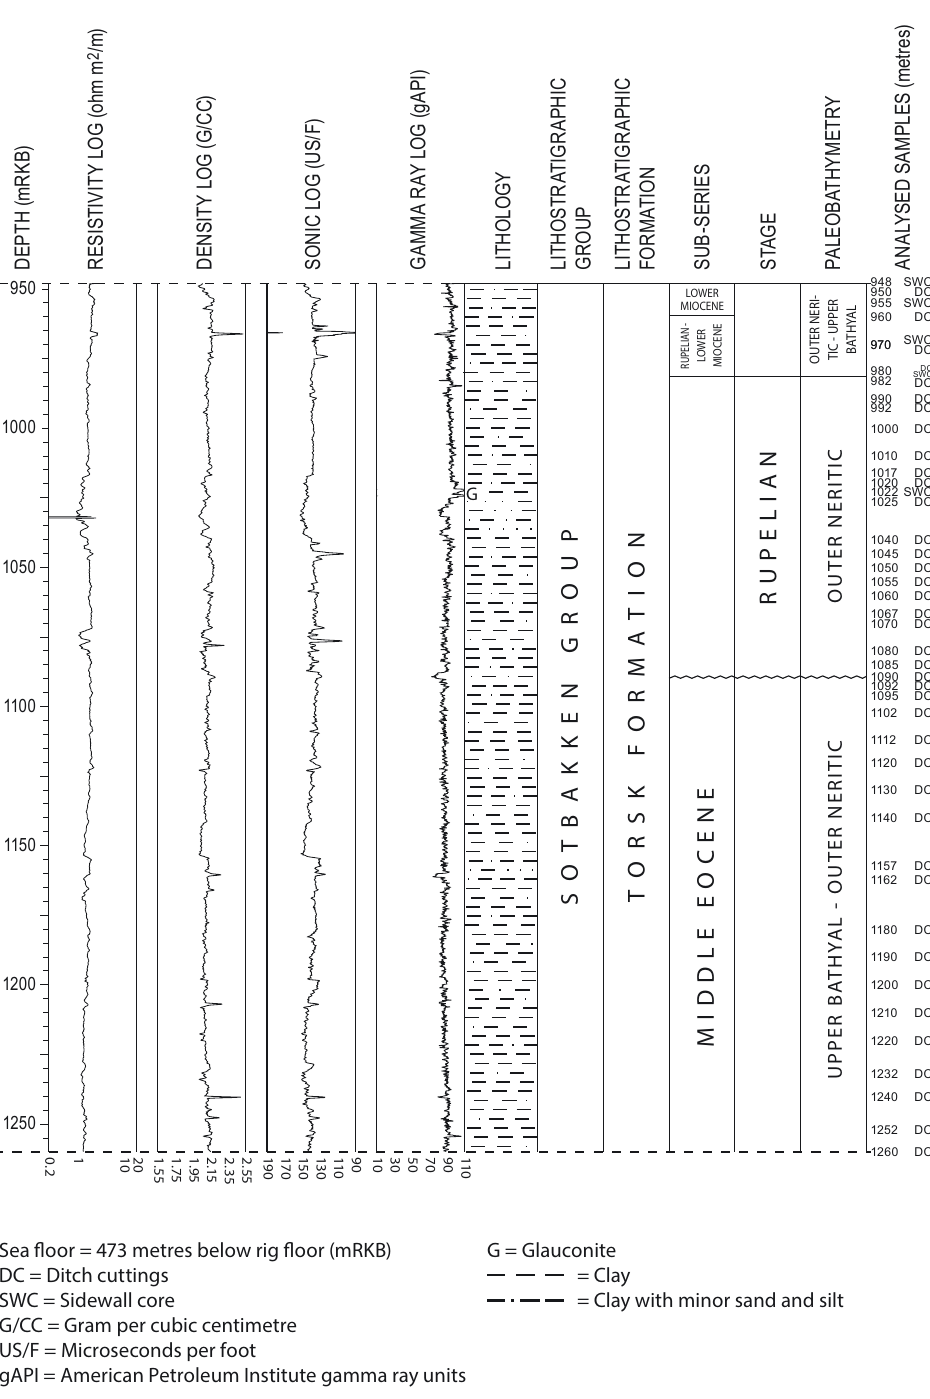
Figure 14. Well summary figure including resistivity log, density log, sonic log, gamma-ray log, lithology, litho- stratigraphic units, sub-series, stage, paleobathymetry and analysed samples for the middle part of the investigated sequence in well 7316/5–1 (middle Eocene to lower Miocene) including the second upper portion of the supplementary Fig. 14 well reference section for the Torsk Formation (modified after Eidvin et al., 1995, 1998b,